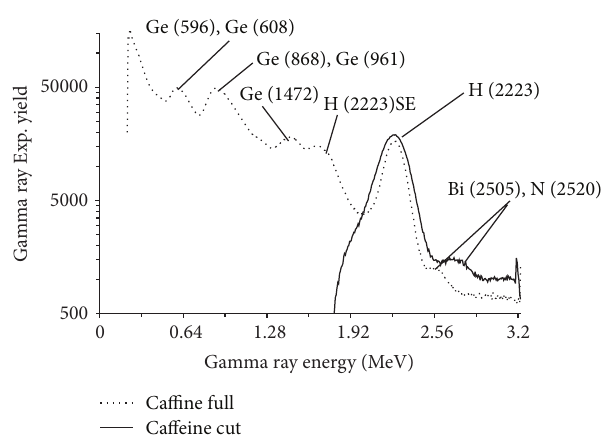
Figure 5: Prompt gamma ray experimental pulse height spectra from caffeine sample over 0–3.22 MeV taken with the BGO detector. Also superimposed is lower energy part suppressed caffeine sample pulse height